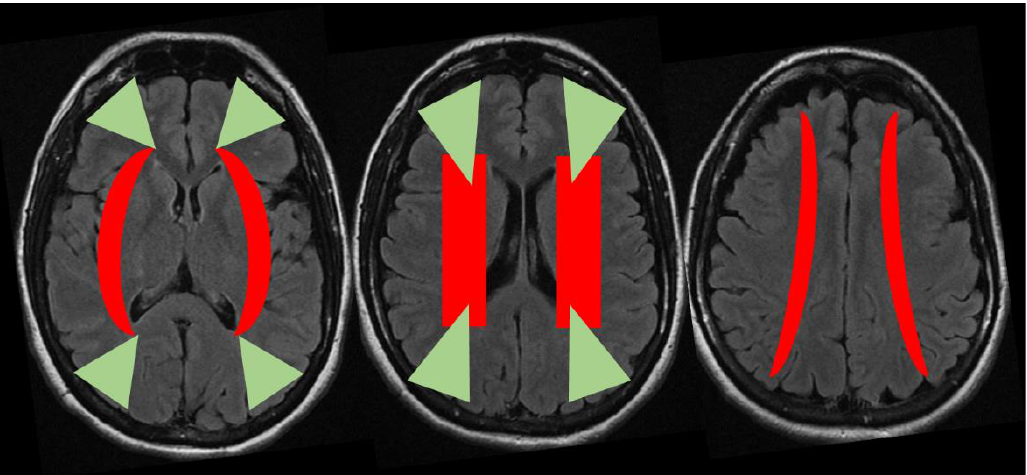
Figure 5. Putative location of the external (green) and internal (red) border zones superimposed on three sequential axial slices of brain MRI (FLAIR sequence). Abbreviations: FLAIR: Fluid Attenuated Inversion